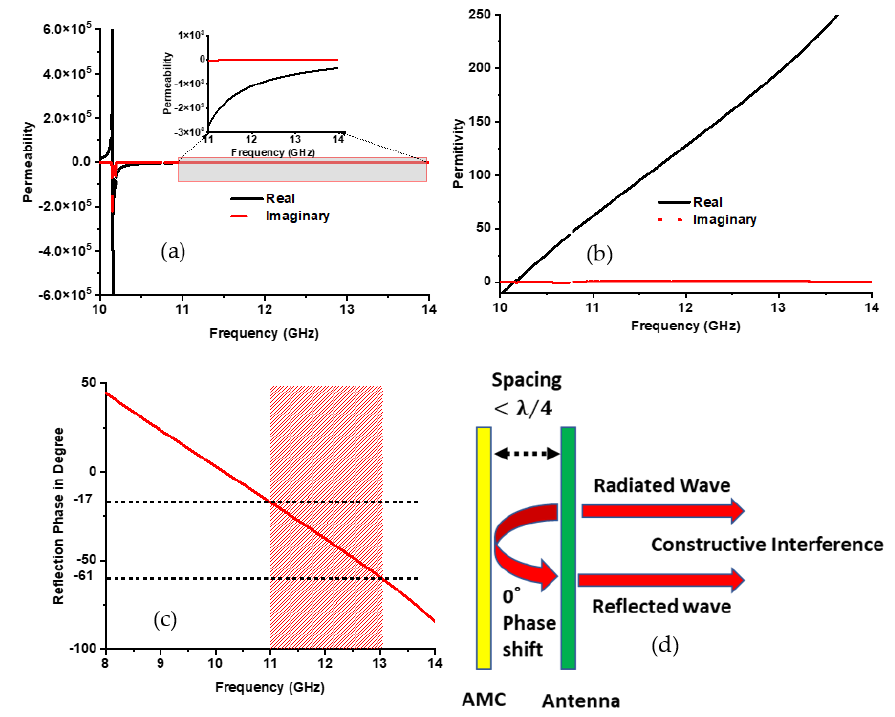
Figure 2. Metamaterial characteristics ( a ) permeability; (b ) permittivity. ( c ) reflection phase, and ( d ) AMC wave interference.